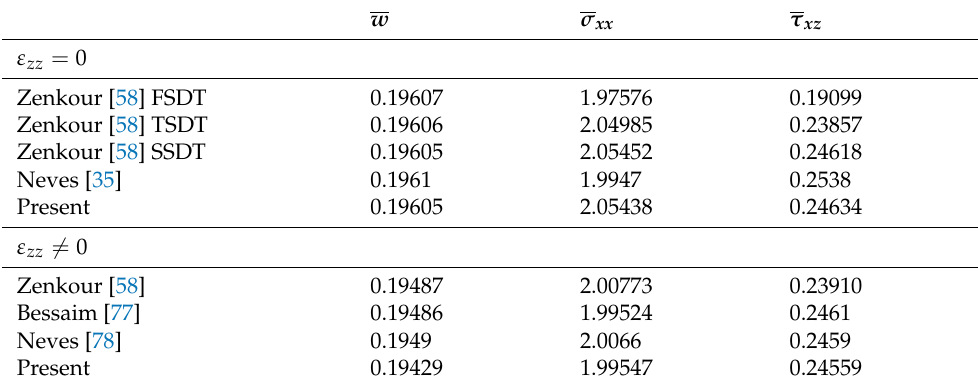
Table 4. Dimensionless central deflection, normal stress and shear stress of square isotropic plate ( E c = 151 GPa, ν c = 0.3 )